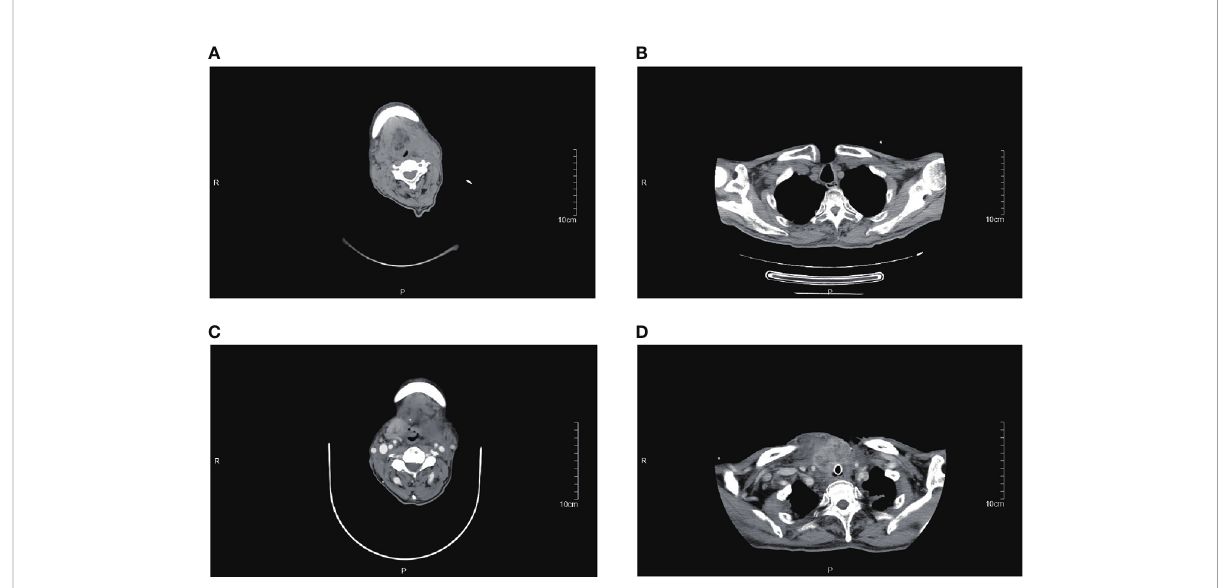
FIGURE 7 CT images of patient #12. (A, B) are from August 2019, and (C, D) are from December 2019. This patient suffered a rapid enlargement of the right upper cervical and mediastinal lymph nodes in just 4 months and died in December